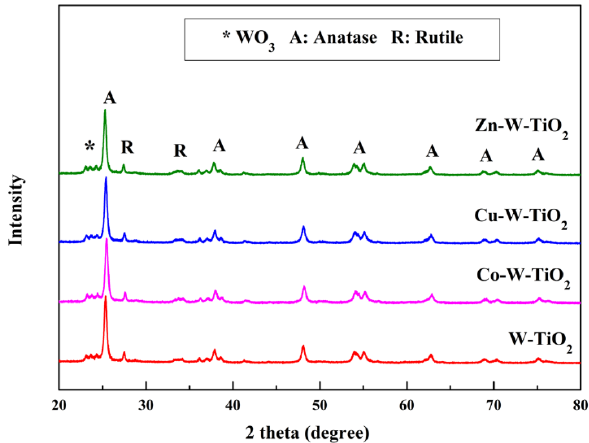
Figure 2. XRD patterns of Mo ‐ TiO 2 , Co ‐ Mo ‐ TiO 2 , Cu ‐ Mo ‐ TiO 2 , and Zn ‐ Mo ‐ TiO 2 .